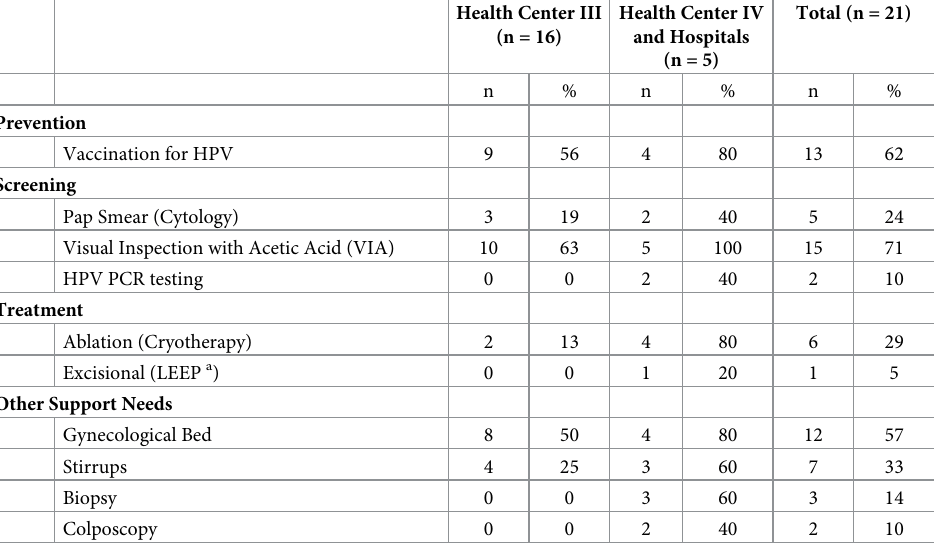
Table 2. List of resources available by facility level.